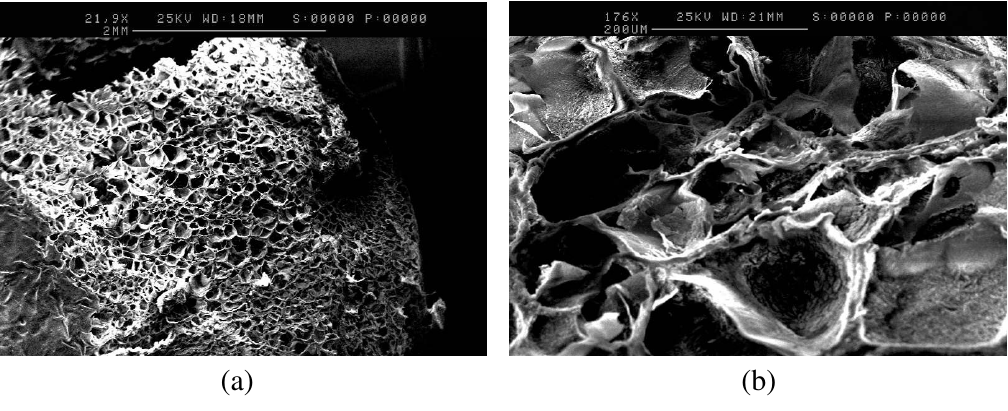
Figure 3. ( a ) SEM image of the tablet matrix of the control formulation. Horizontal Sample. Low Magnification, ×22; ( b ) SEM image of the tablet matrix of the control formulation. Horizontal Sample. High Magnification,